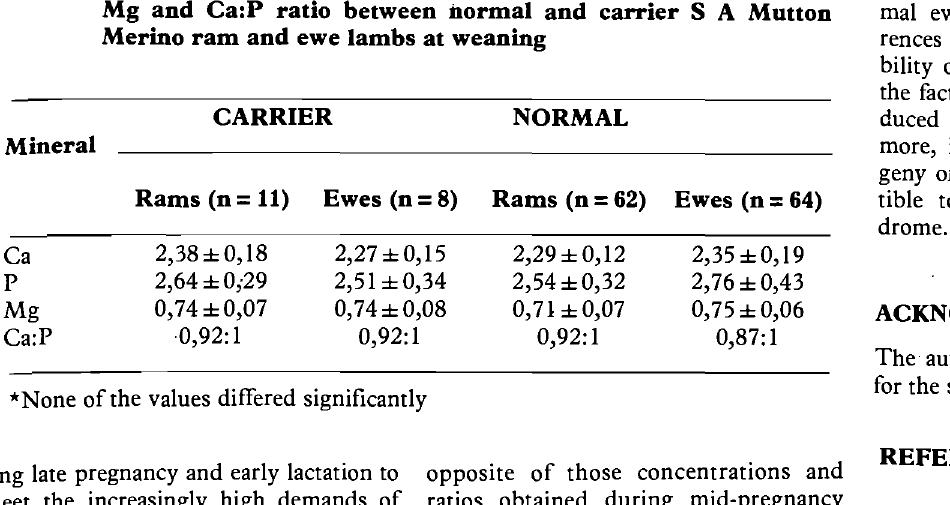
Table 8: A comparison of the mean concentrations* (mmol £-1) of Ca, P, Mg and Ca:P ratio between normal and carrier S A Mutton Merino ram and ewe lambs at